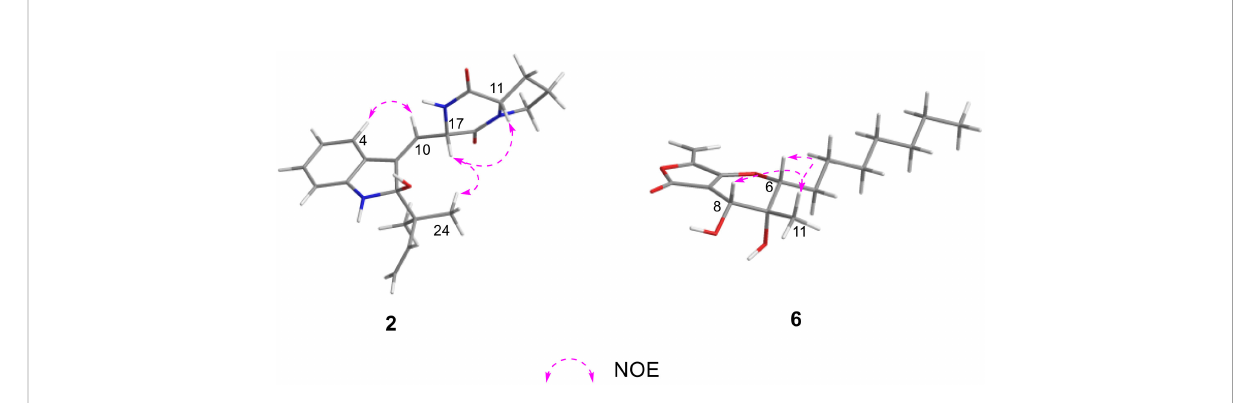
FIGURE 4 Key NOESY correlations of 2 and 6